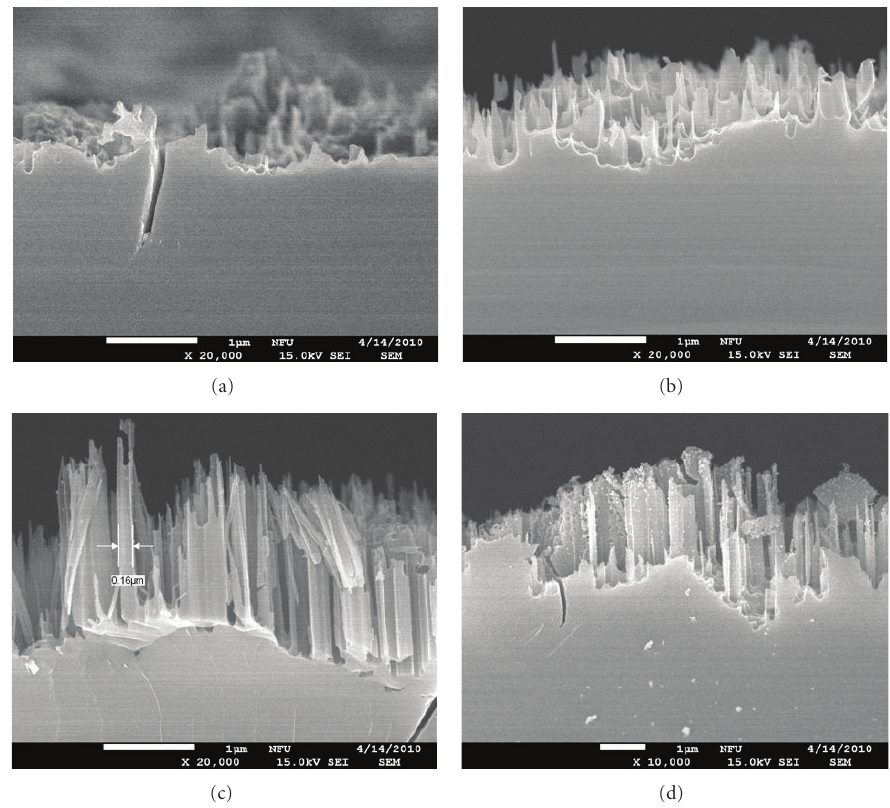
Figure 2: SEM images of various SNW/p-Si(100) structures. Etching conditions were aqueous AgNO 3 /HF/H 2 O mixture chemical solution in a ratio of (a) 2:34 :164, (b) 4 :34:162, (c) 6: 34:160, and (d) 8:34 :158 (volume) at 25 ◦ C for 10 min. The concentration of AgNO 3 was 1molL − 1